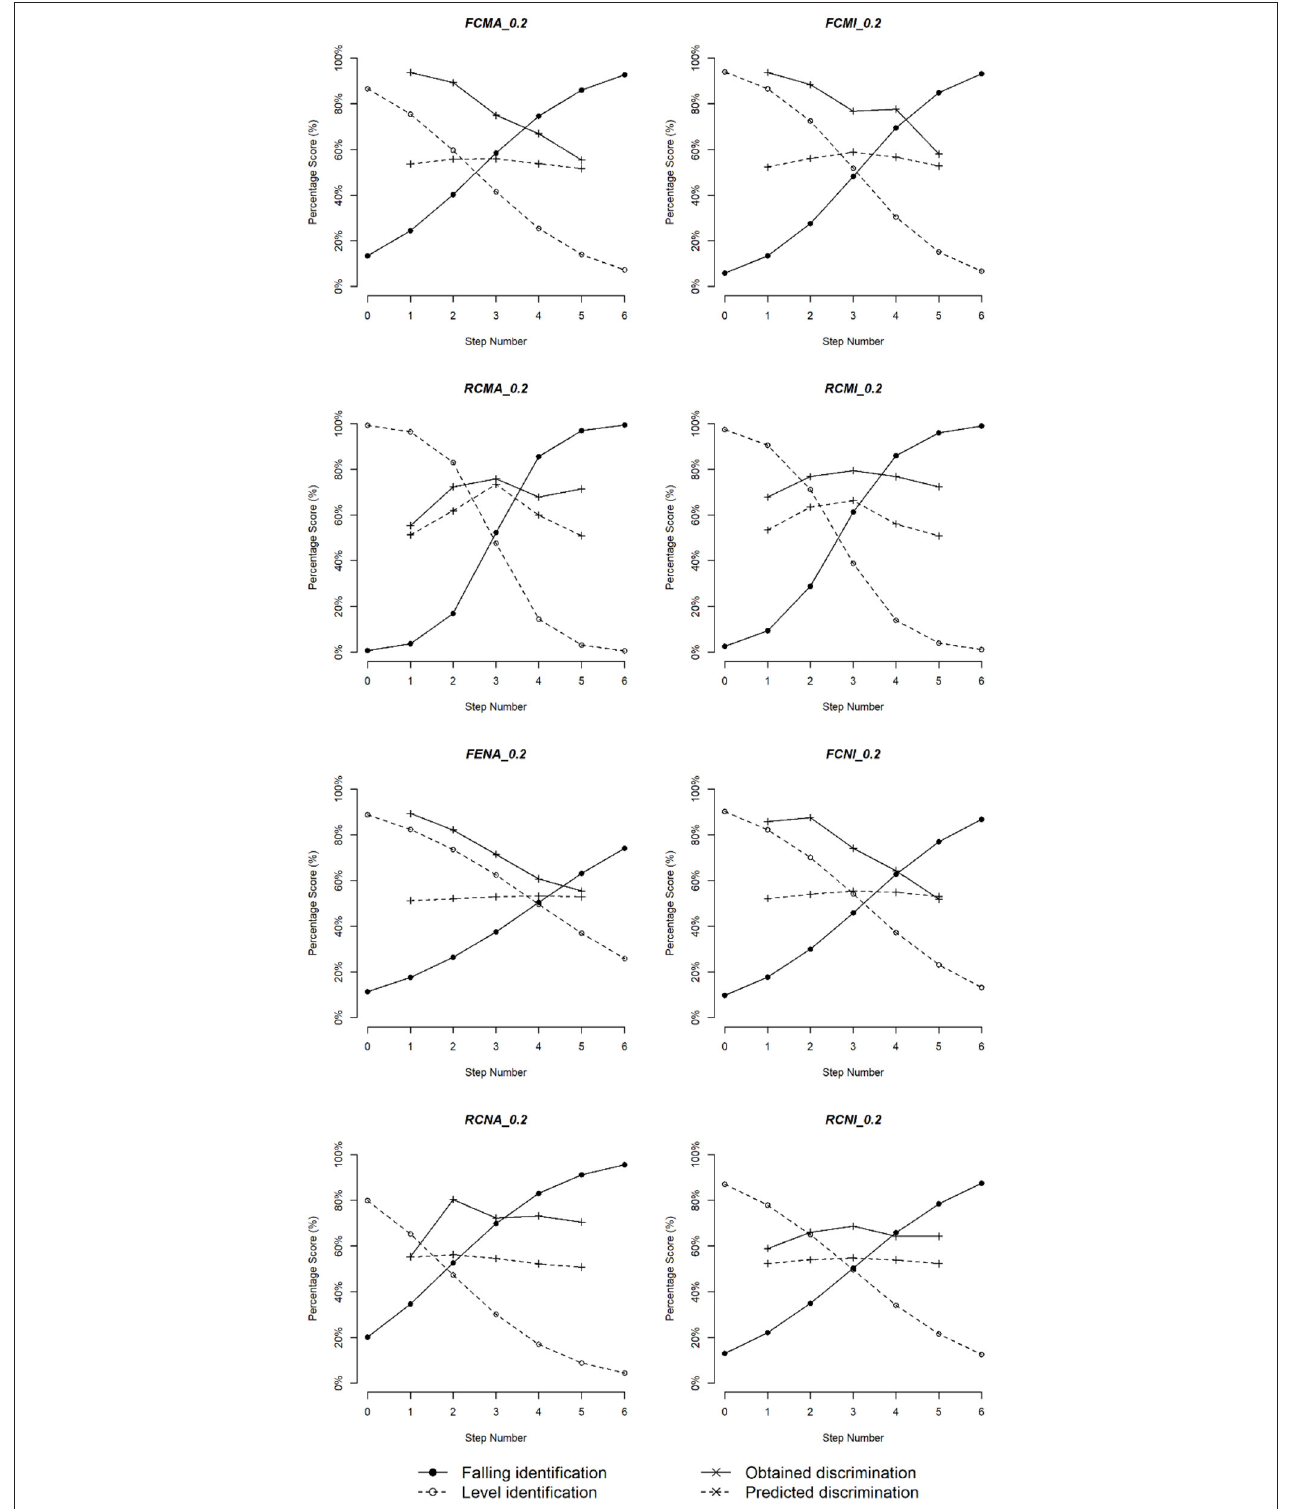
FIGURE 6 | Logistic identification functions and discrimination curves for eight subgroups of Cantonese speakers with duration 200ms.